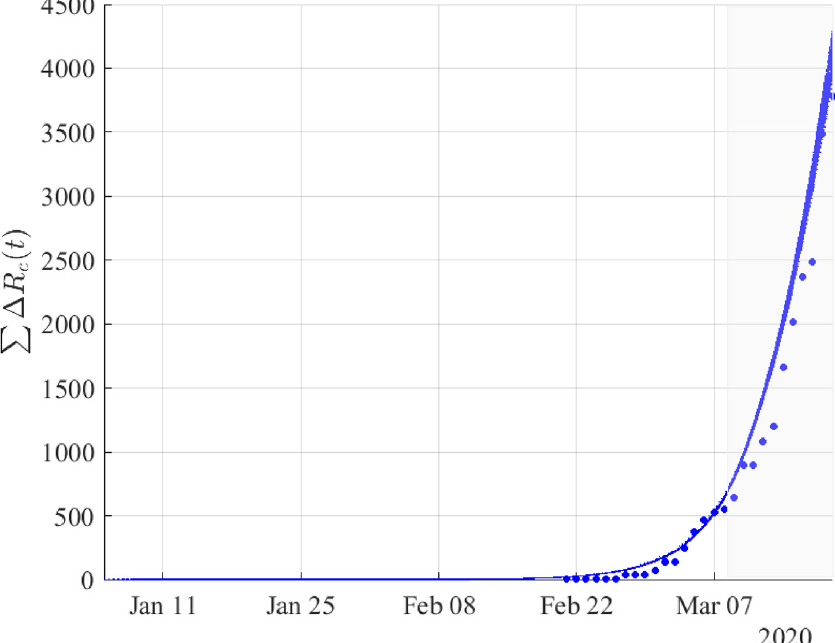
Fig 3. Cumulative number of recovered cases R ( t ) resulting from simulations based on the results obtained by c fitting the daily new cases of recovered from February 21 until the 8th of March. The validation of the model was performed using the reported data of confirmed cases from March 9 to March 19 (shaded area) by taking (1-0.4)(1-0.2) reduction in the “effective” transmission rate (see in Methodology) to the lockdown of March 8. Dots correspond to the reported data of confirmed cases of recovered.